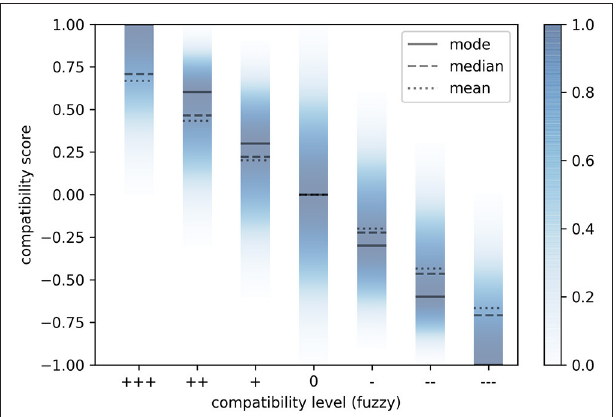
FIGURE 1 | Triangular fuzzy numbers describing the degree of membership of the compatibility score for each qualitative compatibility level. The three descriptors of the distribution that can be used for defuzzifying are also